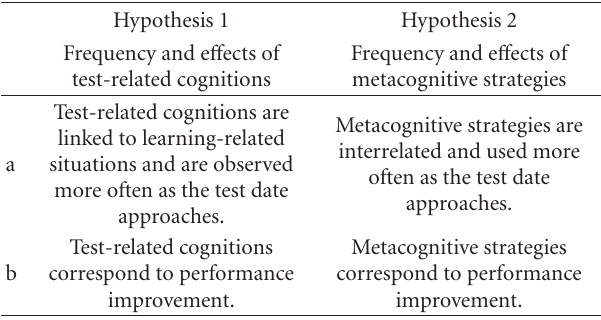
Table 1: Research